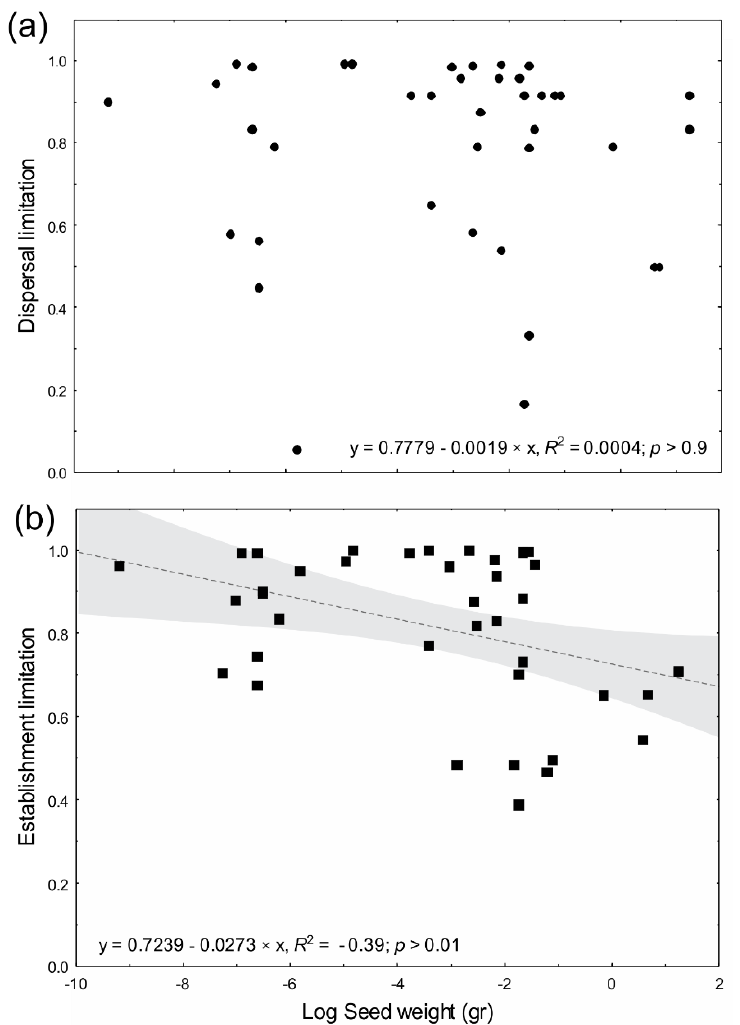
Figure 2. Relationship between: ( a ) seed weight and dispersal limitation; and ( b ) seed weight and establishment limitation ( R 2 = − 0.39; p > 0.01) with regression line; gray shading shows overall relationships fitted with a linear model.